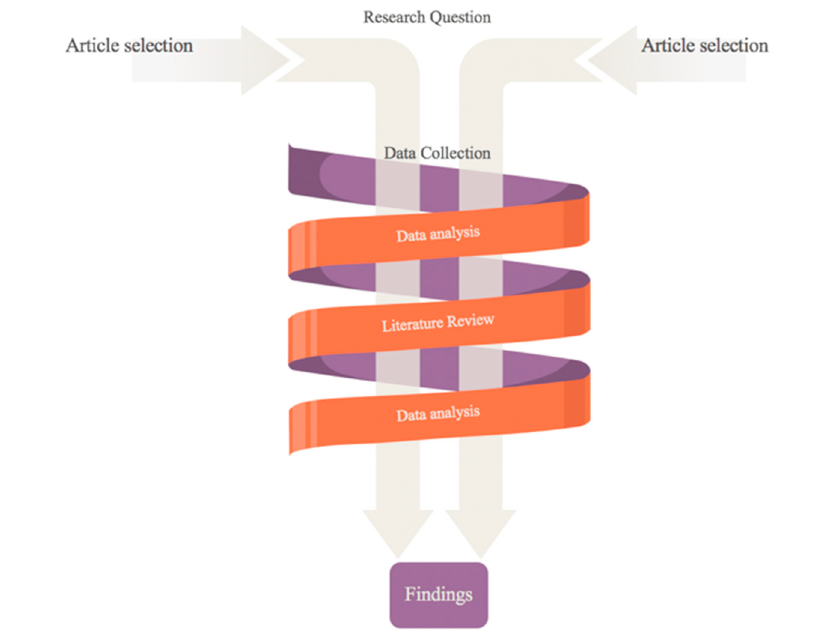
Figure 1. Systematic literature review process .